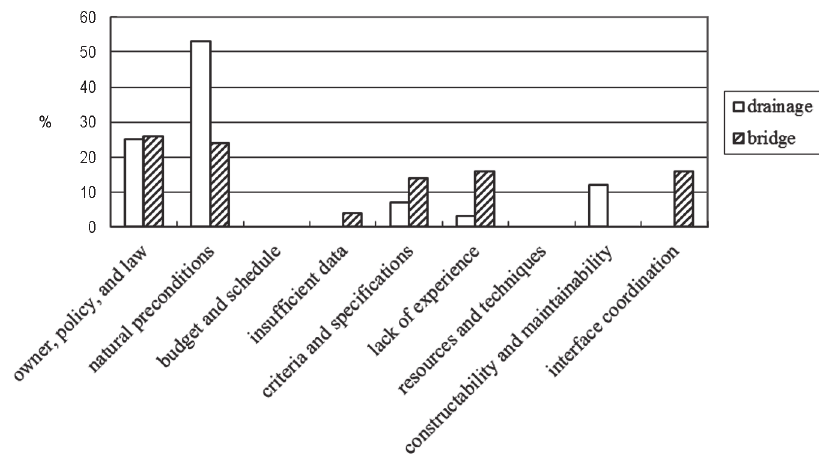
Fig. 4. Proportions of difficulty reasons in sustainable drainage and bridge